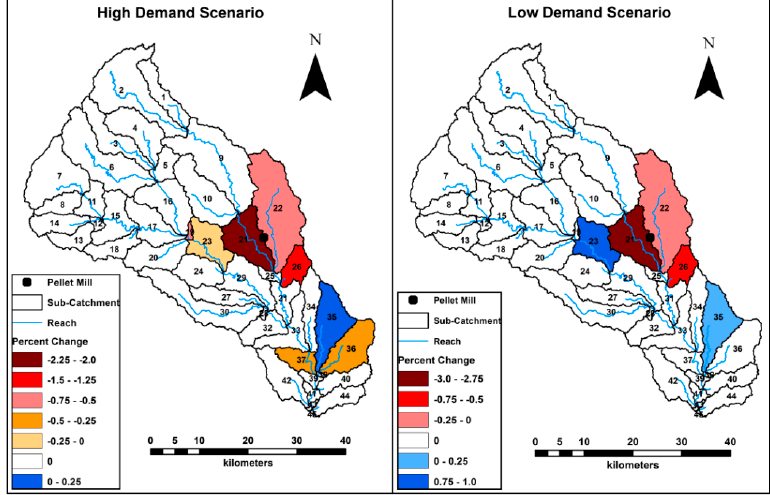
Figure 11. Percent change in evapotranspiration (ET) under the High and Low Demand scenarios for industrial wood pellets at the sub-watershed level.